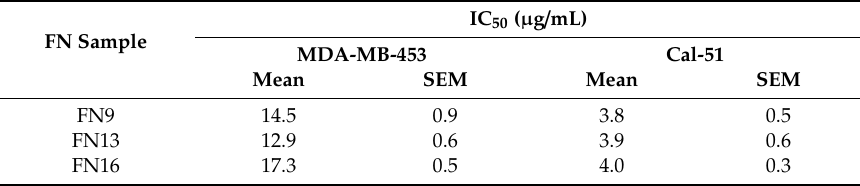
Table 4. Cytotoxic e ffi cacy of FNs against triple-negative breast cancer cells (TNBC). FN Sample